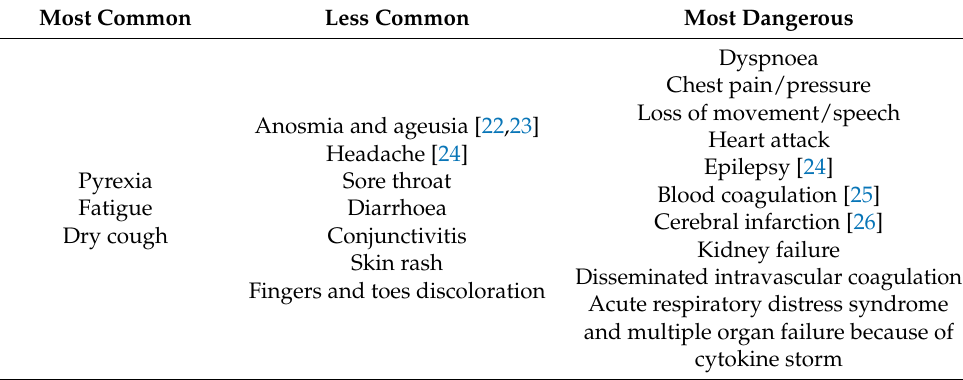
Dyspnoea Chest pain/pressure Loss of movement/speech Heart attack Epilepsy [24] Blood coagulation [25] Cerebral infarction [26] Kidney failure Disseminated intravascular coagulation Acute respiratory distress syndrome and multiple organ failure because of cytokine storm